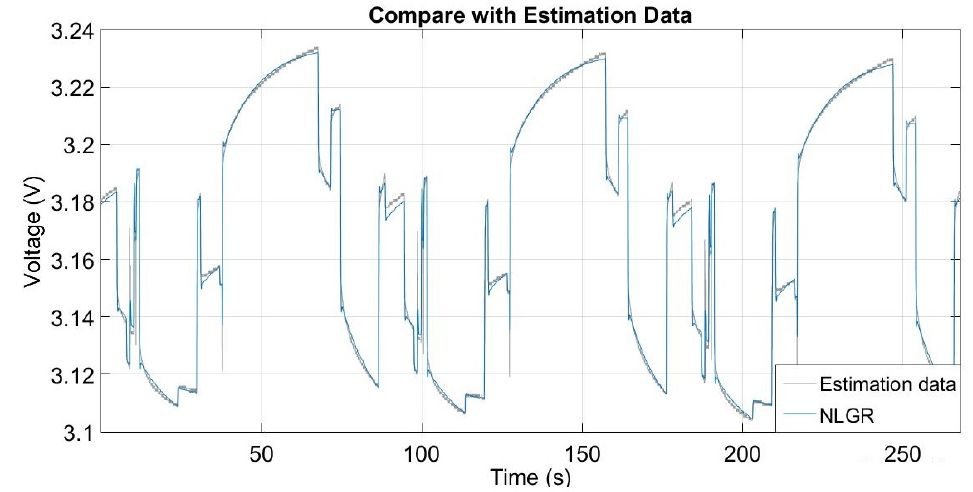
Figure 12. NLGR estimation data result with the best experiment design.